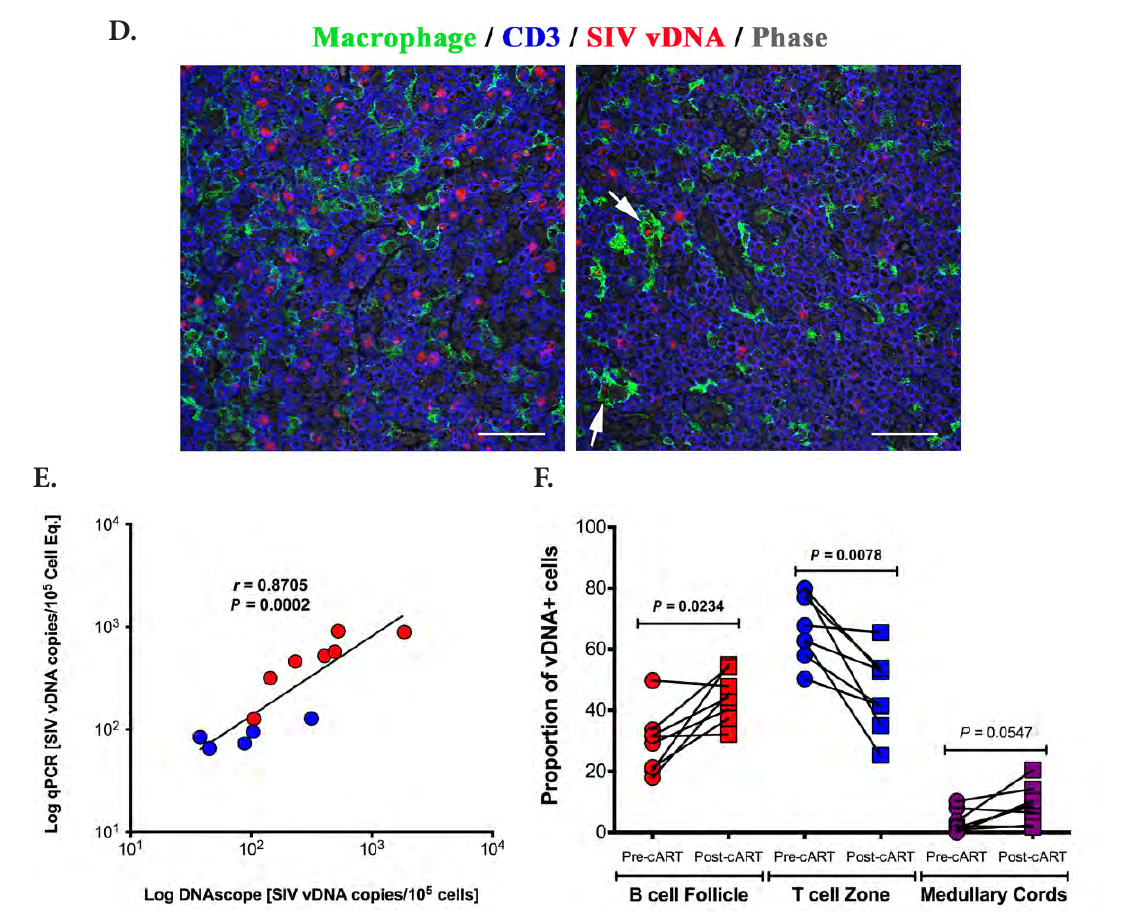
Figure 5. Characterization of vDNA+ cells in secondary lymphoid tissues in vivo . (A) Visual and (B) quantitative comparison of DNAscope to RNAscope and IHC for SIVp17 protein using an SIV-infected (acute) NHP model showed no effect of RNase treatment in the ability to detect vDNA in situ, where- as RNAscope detection of vRNA is highly sensitive to RNase pretreatment. P values were based on the Mann-Whitney test. Scale bars = 200 µm. (C) Confocal analysis of an acutely SIV-infected lymph node demonstrating the ability to combine vDNA detection (red) with cell phenotypic immunofluorescence analysis of CD3+ T cells (green), and CD68+/CD163+ myeloid lineage cells (blue) demonstrating the pre- dominant infected cell type to be T cells. Arrows point to examples of “superinfected” T cells that contain multiple vDNA copies per cell. Scale bars = 25 µm. (D) Confocal analysis of an acutely SIV-infected lymph node demonstrating rare vDNA detection (red) in CD68+/CD163+ myeloid lineage cells (green) demon- strating the predominant infected cell type to be T cells (blue). Scale bars = 25 µm. (E) Strong statistically significant correlation of the number vDNA+ cells before and during cART, as determined by DNAscope and qPCR quantification on a per cell basis. Data were log10 transformed and P values were based on as- sociations between paired comparisons using the Pearson’s Correlation test. (F) Visualization and quantifi- cation of vDNA+ cells by DNAscope allowed for the discrimination of the anatomical location of vDNA+ cells within intact tissues. Using an SIV RM model of cART we noted significant changes in the propor- tions of vDNA+ cells within the distinct lymph node anatomical sites, similar to results seen in vRNA+ cell frequency changes reported in Figure 4. P values were based on the Wilcoxon matched-pairs signed rank